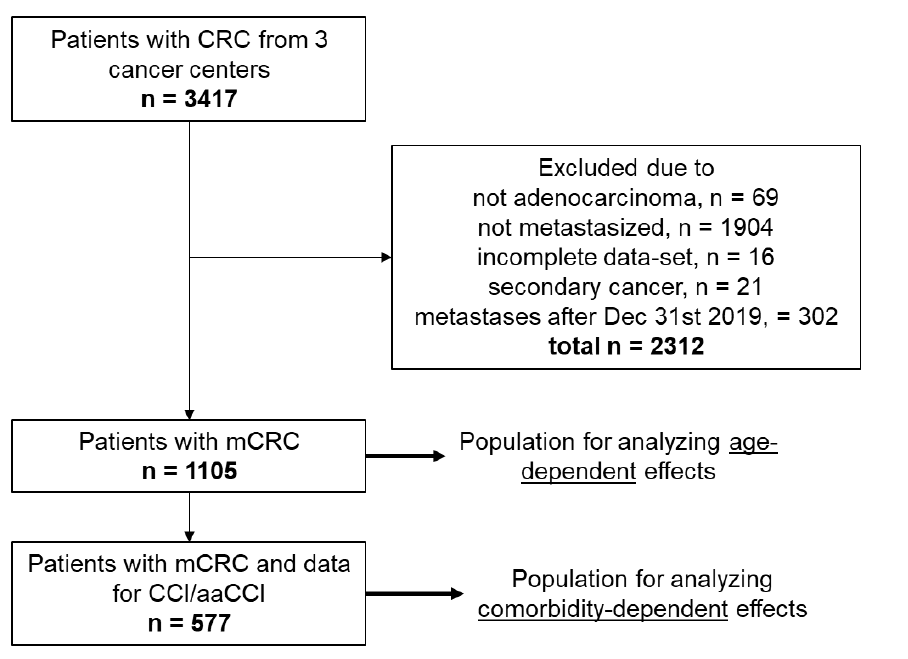
Figure 1. Patient selection. Table 1. Patient